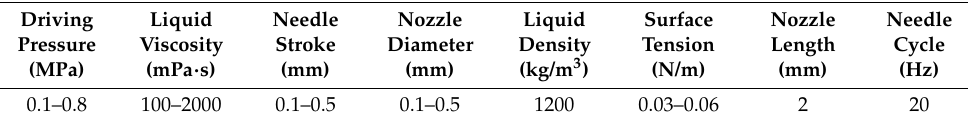
Table 1. The ranges of simulation